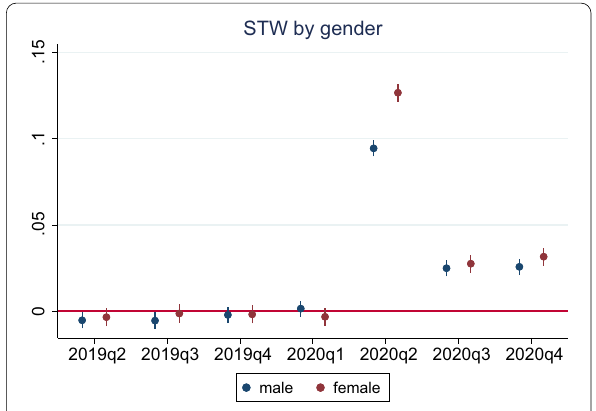
Fig. 8 STW over time for men and women. Notes Estimates from regression (3) of STW dummy on quarterly dummies, run separately for men (blue) and women (red). Regressions estimated with linear probability model, including random effects